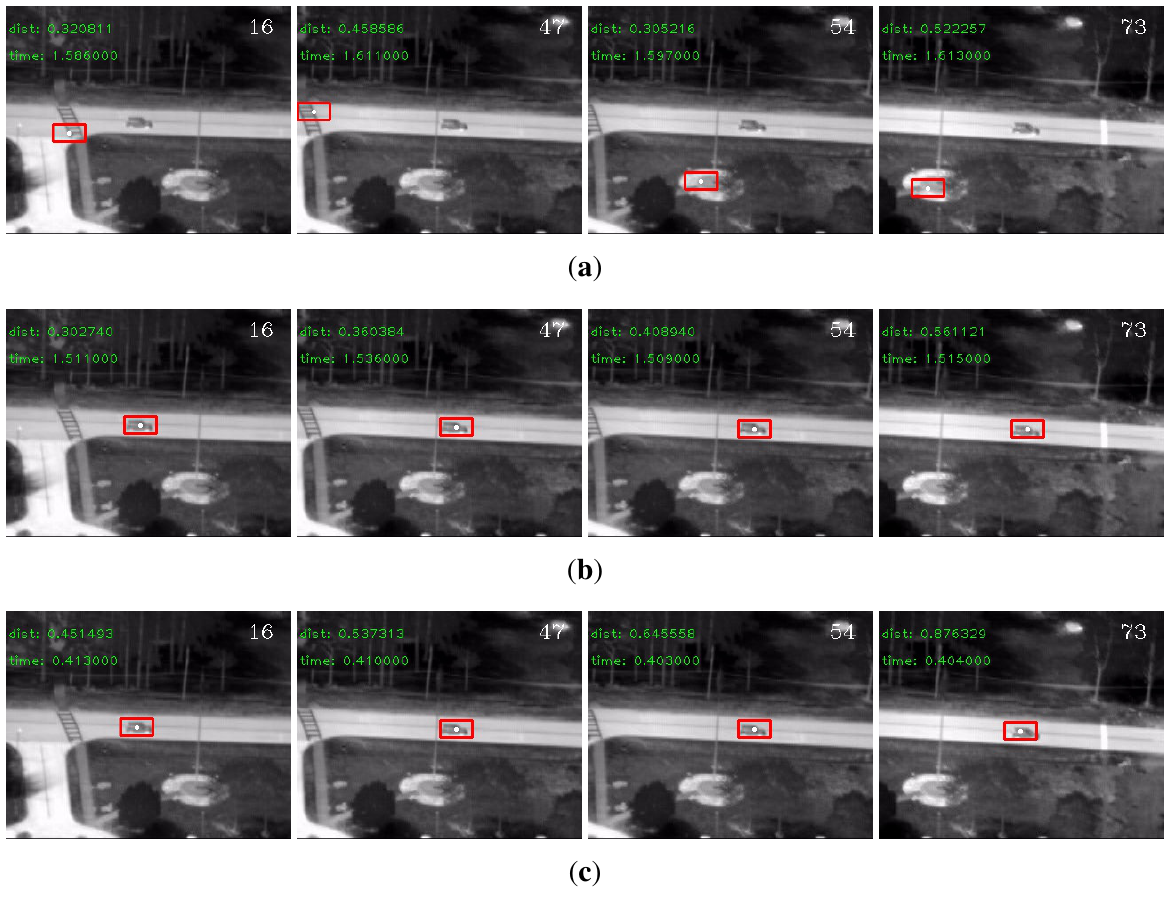
Figure 2. Some detection results for the “PkTest01” sequence ( a ) using the conventional covariance descriptor, ( b ) using the regularized covariance descriptor and ( c ) using the adaptive covariance descriptor. The initial frame with the target object marked in rectangle is shown in Figure